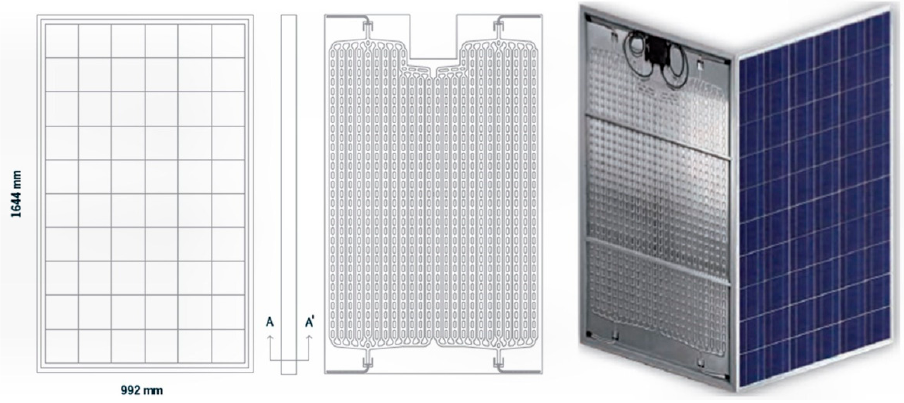
Figure 3. Janus PVT collector. Table 3. Design features of PVT Janus collector, water circulation pump.